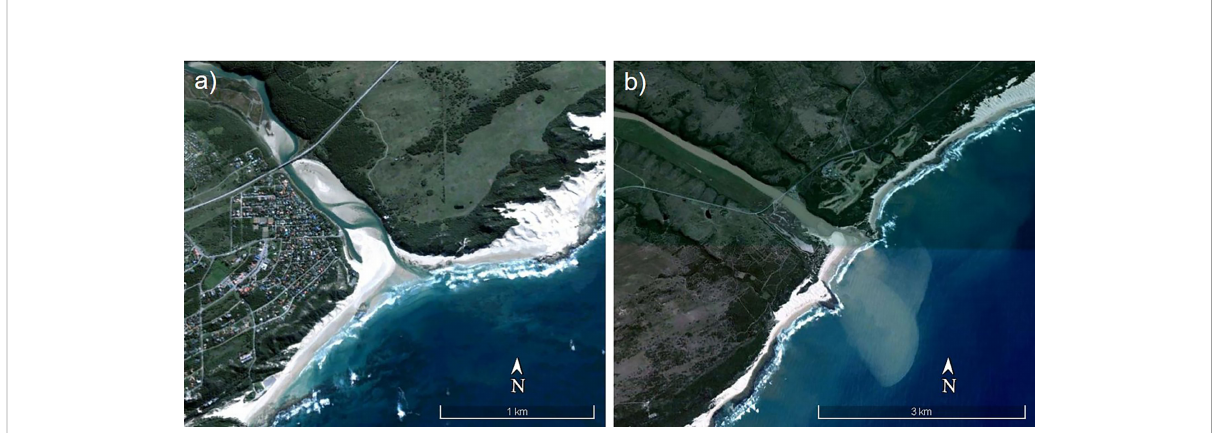
FIGURE 4 Turbidity plumes adjacent to the two study estuaries (A) Google Earth Pro V 7.3.3.7786. (6 December 2003). The lower reaches and adjacent nearshore of the Kariega Estuary -33.683882; 26.684485, Eye alt 4.49 km. Maxar Technologies 2022. http://www.earth.google.com [14 May 2022] and (B) Google Earth Pro V 7.3.3.7786. (3 August 2004) the lower reaches and adjacent nearshore of the Great Fish Estuary -33.492921, 27.126729, Eye alt 12.41 km. Landsat/Copernicus 2022, Maxar Technologies 2022. http://www.earth.google.com [14 May